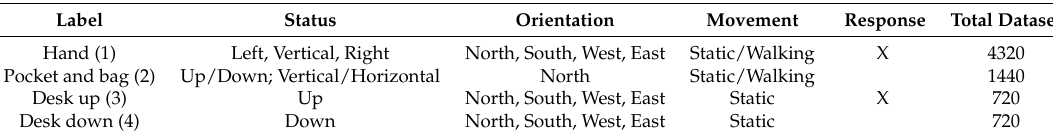
Table 4. Details of the training